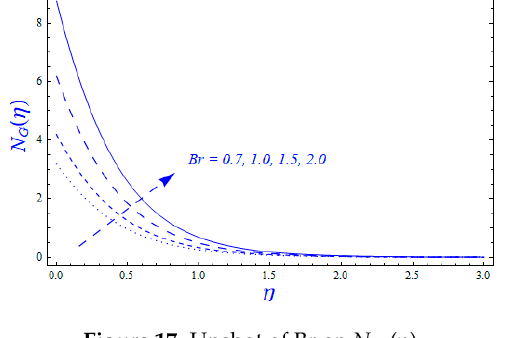
Figure 17. Upshot of Br on N G ( η ).